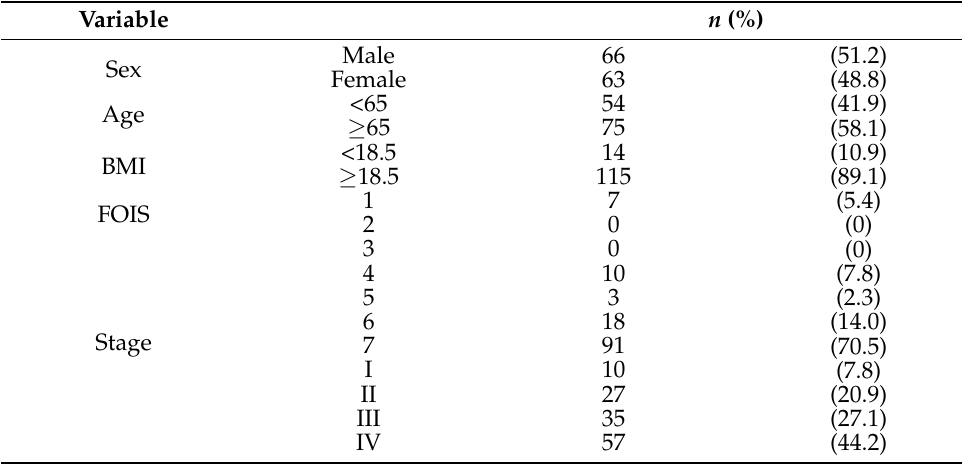
Table 1. Baseline characteristics of patients with oral ( n =